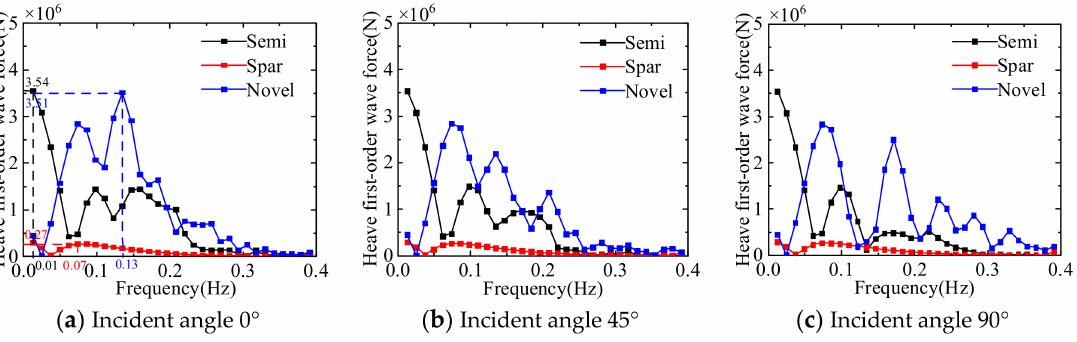
Figure 13. Comparison of the first-order wave force in heave direction of three floating platforms. The comparison of the first-order wave moments in the rotation direction of the three floating platforms is presented in Figures 14–16. The roll first-order wave moment is significantly affected by wave frequency; the maximum roll first-order wave moment for both the semi-submersible platform and the novel platform occurs at a 45 ◦ incident angle. The maximum roll first-order wave moment for the Spar platform occurs at a 90 ◦ incident angle. The maximum pitch first-order wave moment of the semi-submersible platform and the novel platform appear at 0 ◦ and 90 ◦ incident angles and the pitch first-order wave moment of the Spar platform decreases with the increase of the wave incident angle. The maximum yaw first-order wave moment of the semi-submersible platform and the novel platform appear at 90 ◦ incident angle, and the first-order wave moment of the Spar platform is not affected by the wave